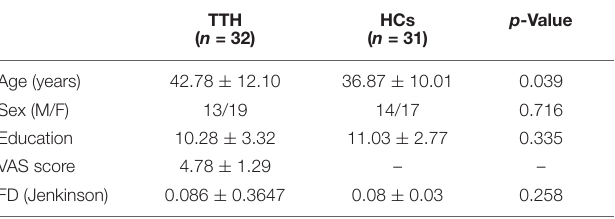
TABLE 1 | Demographic characteristics of all